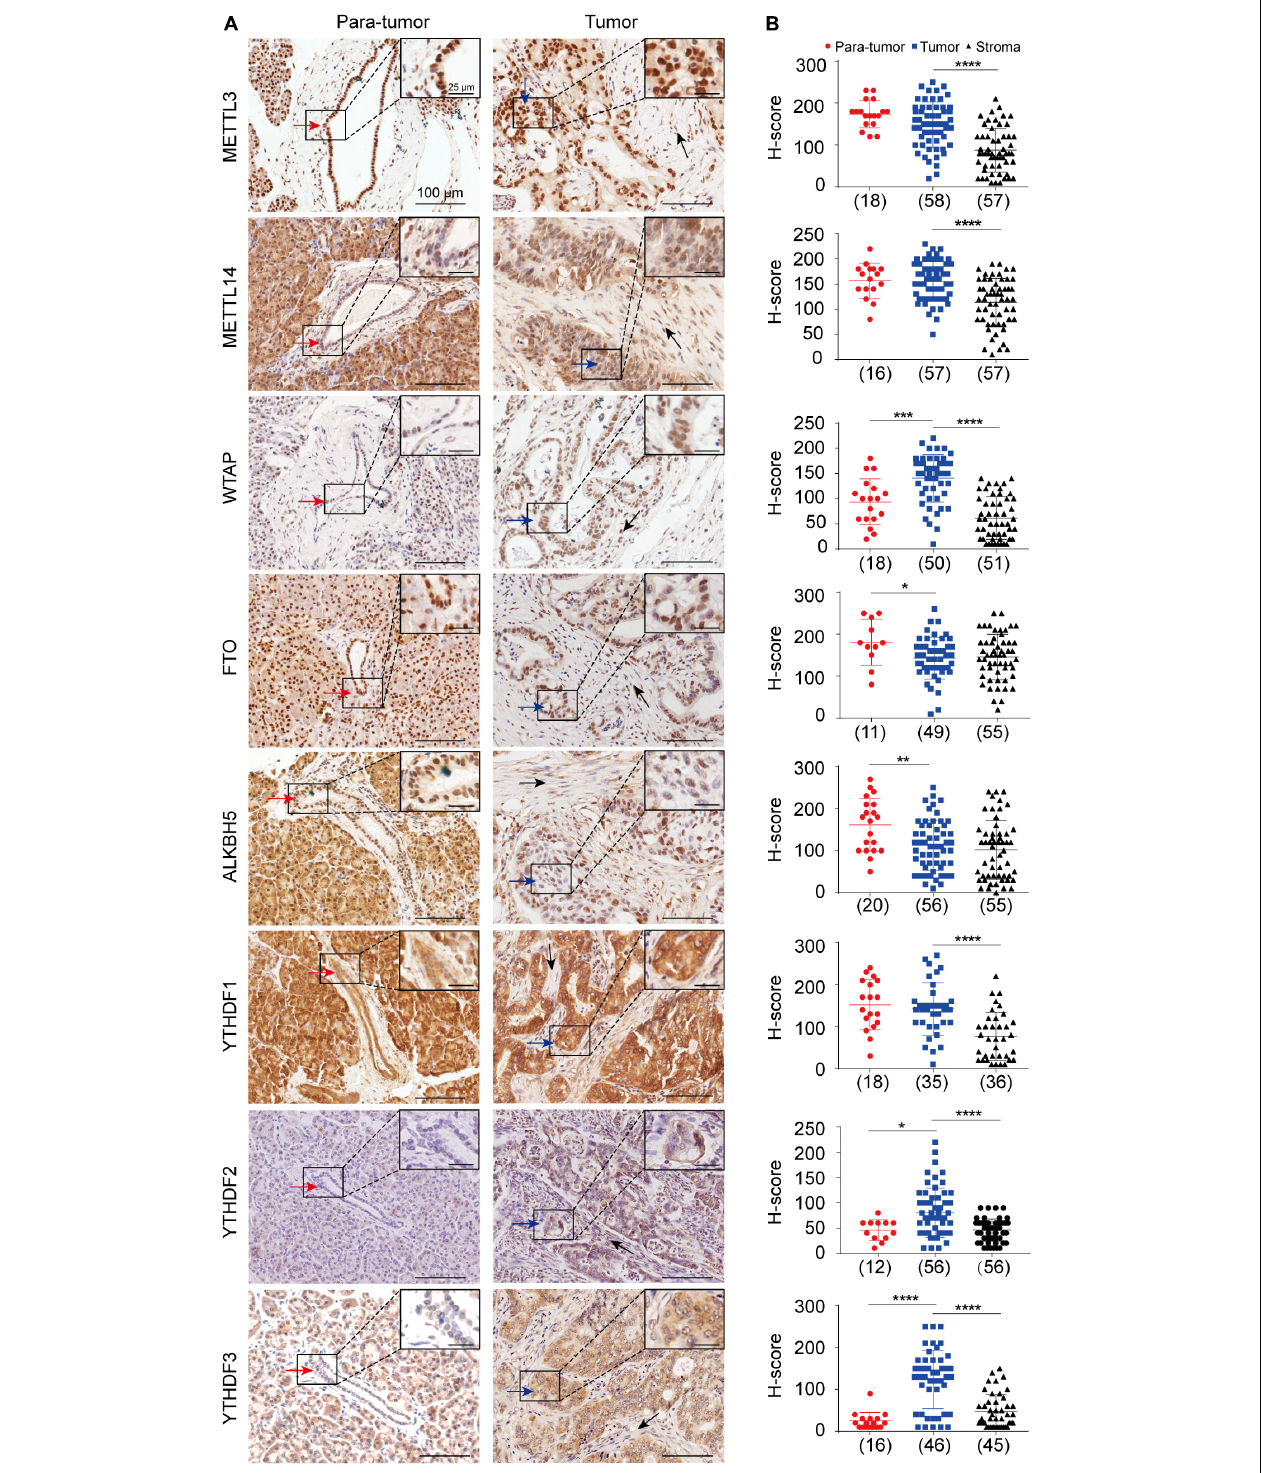
FIGURE 1 | In situ protein expression analysis of eight m 6 A key regulators in pancreatic ductal adenocarcinoma (PDAC). (A) Representative immuno-histochemical staining showing the expressions of METTL3, METTL14, WTAP, FTO, ALKBH5, and YTHDF1-3 in normal pancreatic ductal epithelial cells (red arrows) in para-tumor samples, tumor cells (blue arrows), and stromal cells (black arrows) in tumor samples. Enlarged images in the box are shown in the upper right. (B) Scatter plots showing the H-scores of each gene in para-tumor, tumor and stroma cells are shown in the right panel. Case numbers are shown in brackets. Scale bars, 100 or 25 µ m. * P < 0.05, ** P < 0.01, *** P < 0.001, **** P < 0.0001.